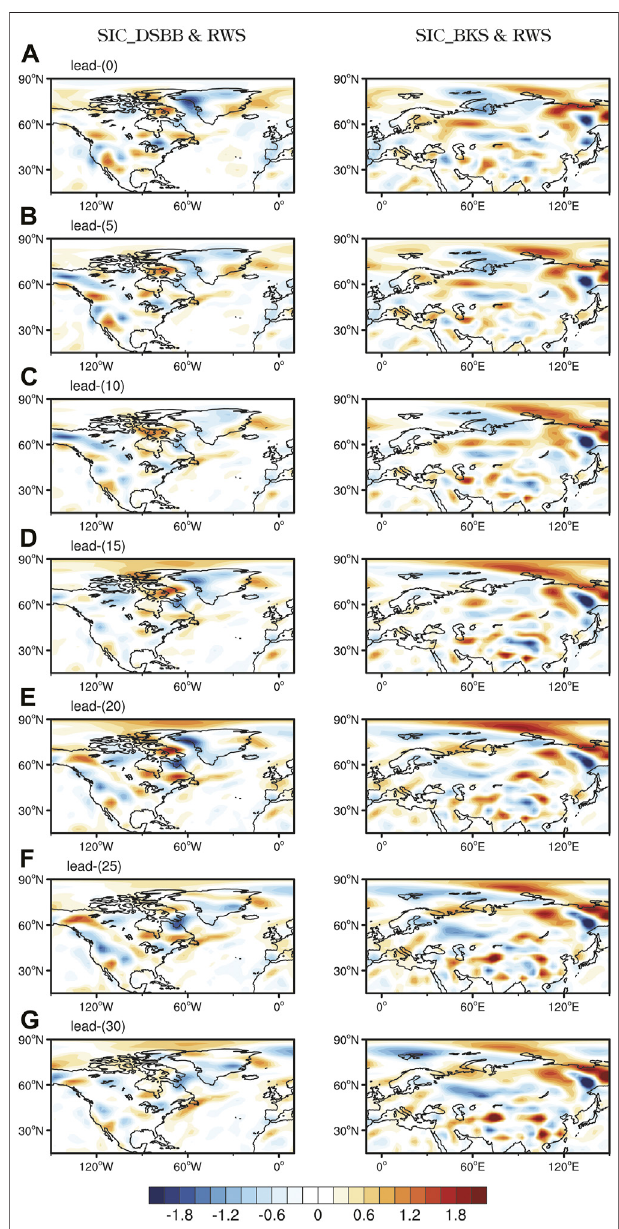
FIGURE 9 | Lag correlations between SIC indices and RWS anomalies (unit:10 – 11 s − 2 )inwinter2014/2015,withtheinteractionsbetweenSIC-DSBB and SIC-BKS removed. The left (right) column is based on SIC-DSBB (SIC-BKS).